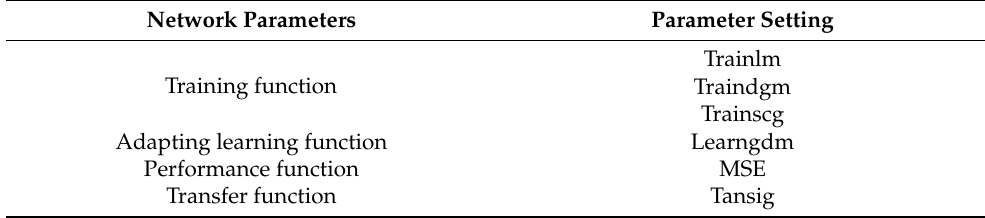
Table 5. BP neural network calculation of the number of neurons in the hidden layer.